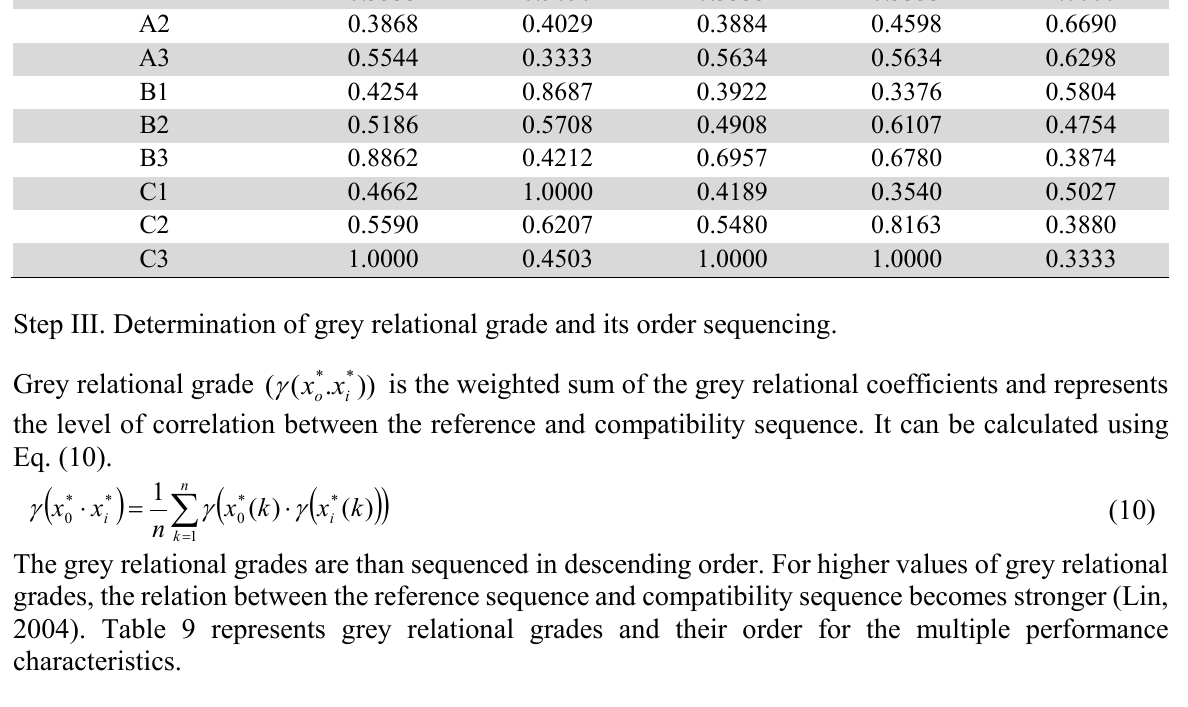
Grey relational coefficient of the responses with  = 0.5 Sample no.